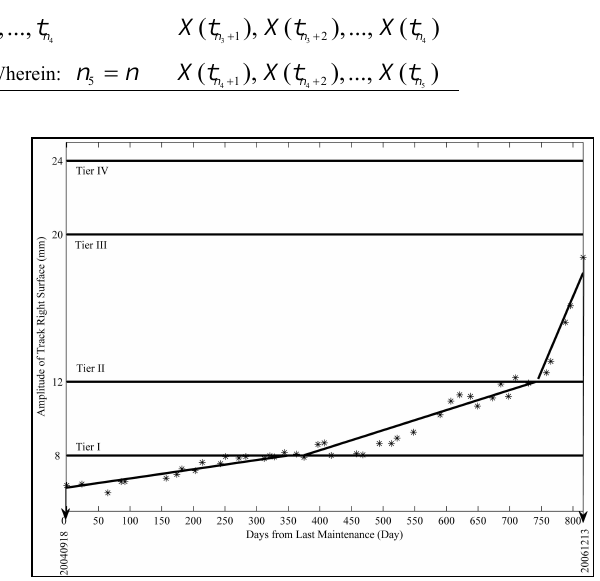
Figure 5 Fitting Results of Right Track Surface at Mileage Point of K669+350 in Jing-Hu Up-Going